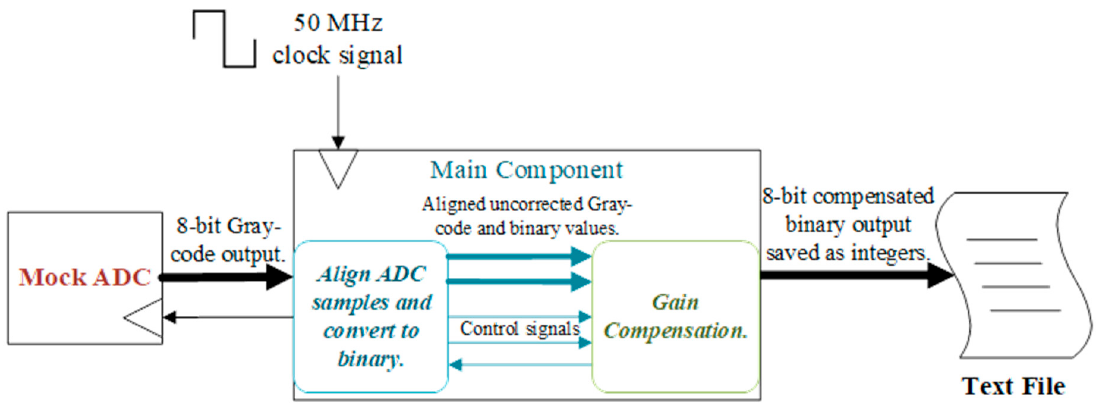
Figure 9. Testing the ADC output with the compensation algorithm.